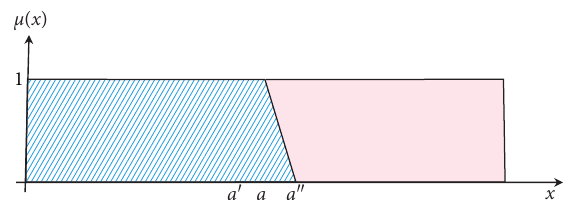
Figure 14: Graphical presentation of fuzzy equality limitations.